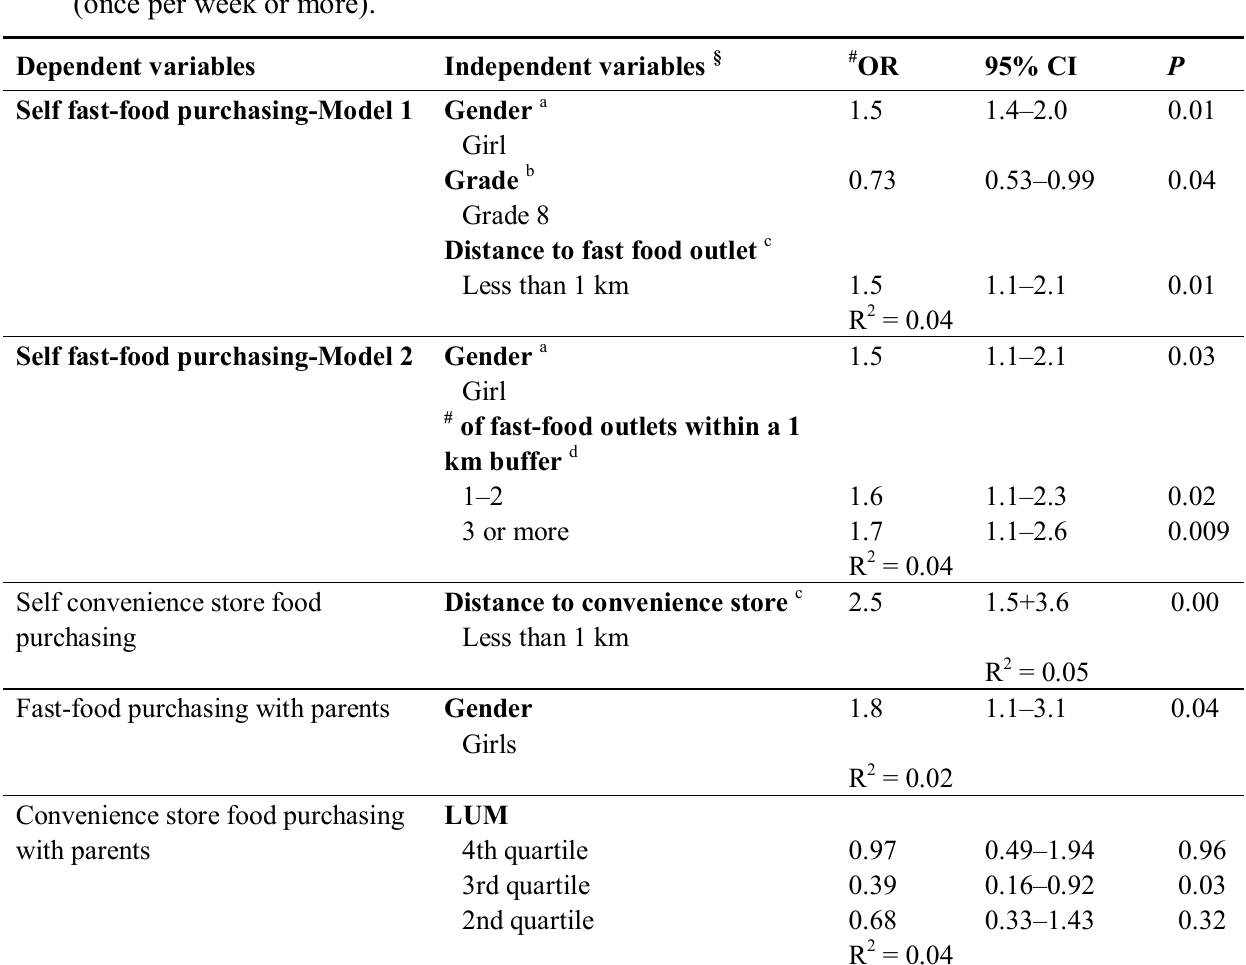
Table 4. Home neighborhood food environment and students’ food purchasing behaviors (once per week or